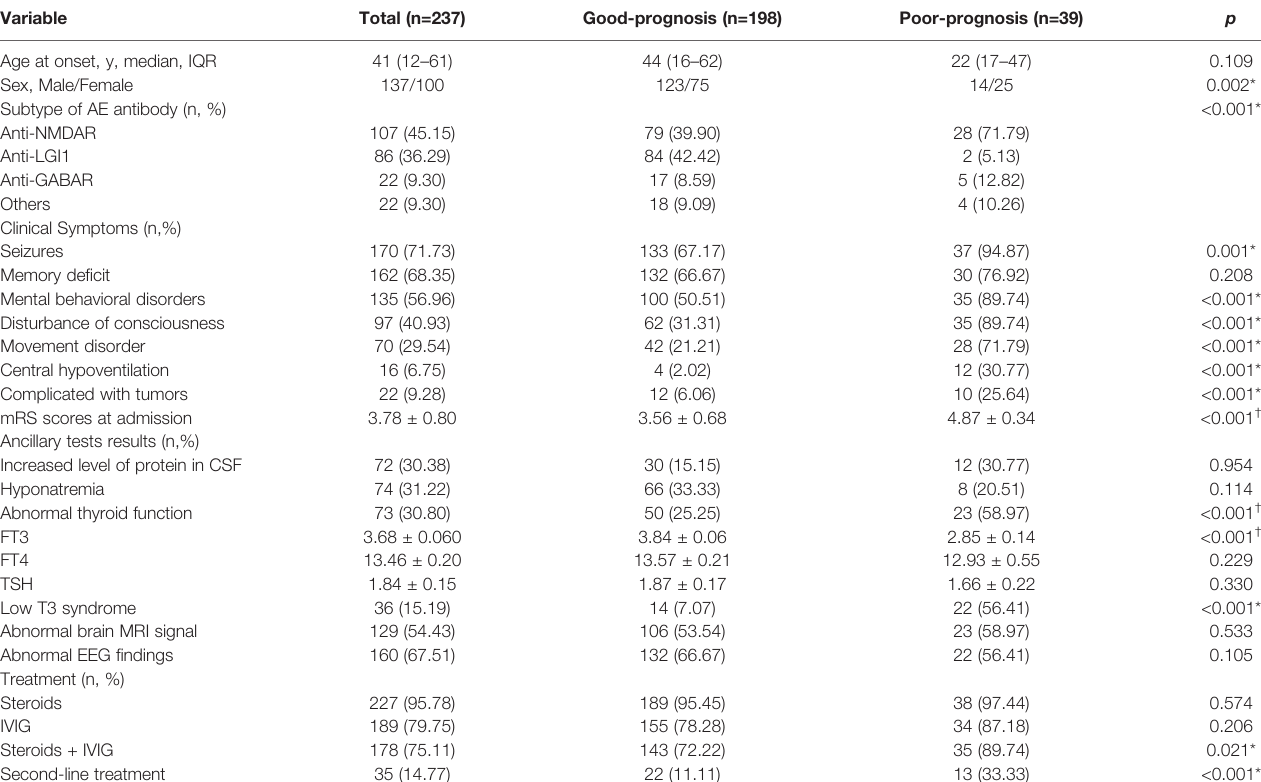
TABLE 1 | Demographics and clinical features of patients with autoimmune encephalitis.